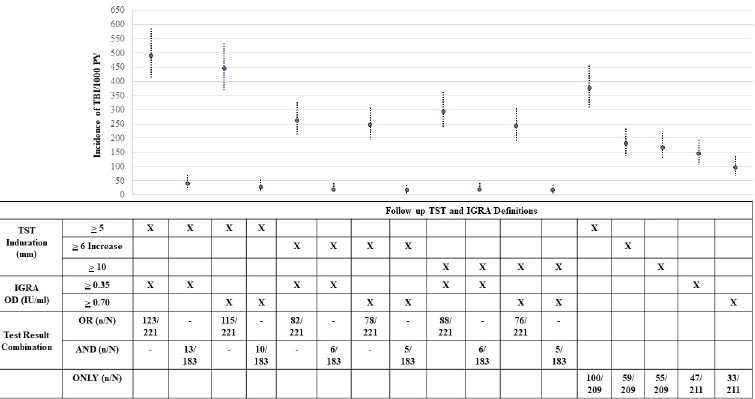
Fig 3. Incidence of TB infection among household contacts of adult pulmonary TB patients in India, stratified by baseline TST and/or IGRA cut offs. Line graph depicting the incident TB infection (iTBI) rates among household contacts (HHC) of adult pulmonary TB (PTB) patients in India, stratified using different thresholds for TST conversion and/or IGRA conversion to define iTBI status. The graph shows the rates of iTBI were higher for lower TST/IGRA conversion thresholds as compared to higher TST/IGRA conversion; and the iTBI rates were higher when the iTBI definition used either test positive (“OR”) criteria as compared to both test positive (“AND”) criteria. In addition, changing the cut-off for a positive IGRA from � 0.35 to � 0.70 IU/ml did not significantly impact the iTBI estimates. However, increasing the induration TST cut-off from � 5 mm to � 10 mm or requiring a � 6 mm increase in induration from previous reading resulted in lower iTBI estimates, regardless of the IGRA cut off used.